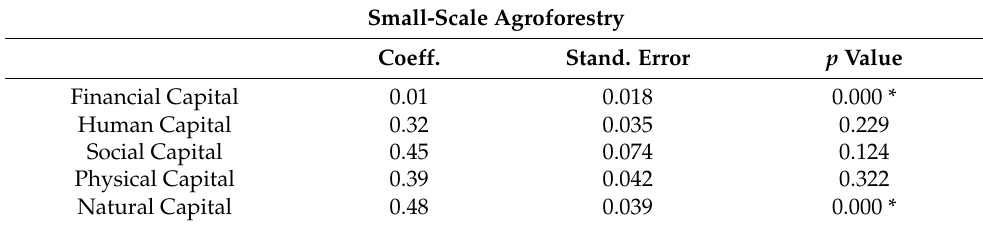
Table 6. Dependent variable: Small-scale agroforestry. Small-Scale Agroforestry Coeff. Stand. Error p Value Financial Capital 0.01 0.018 0.000